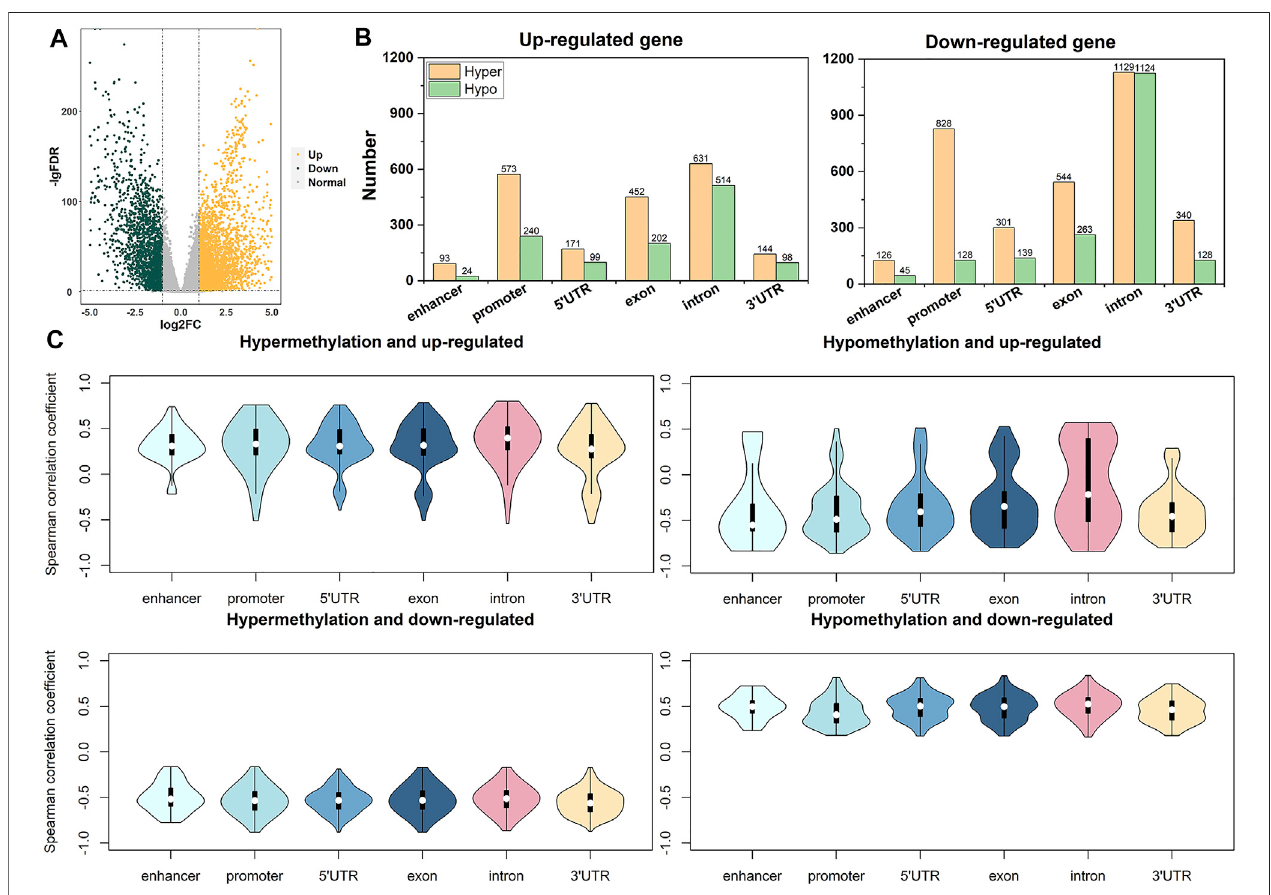
FIGURE 2 | The distribution of correlation coef fi cients between gene expression and DNA methylation. (A) is a volcano map for screening DEGs. (B) is the enrichment number of DNA methylation probes in each region of up-regulated and down-regulated genes. (C) is the correlation between DNA methylation and gene expression in each region of the four types of